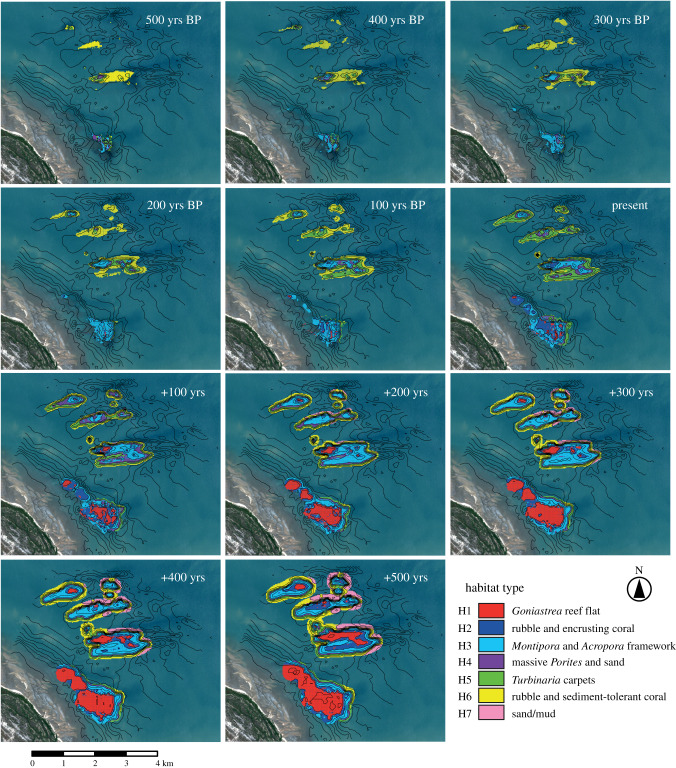
Spatial distribution of reef habitats throughout stages of reef geomorphic development (±500 years from present day). Habitat type (H1–H7) is determined by the relative water level above the reef surface as the reef (de)evolves, and associated coral communities are derived from observations of living coral depth ranges. Black lines denote the seafloor and reef bathymetry for each time interval. (Online version in colour.)